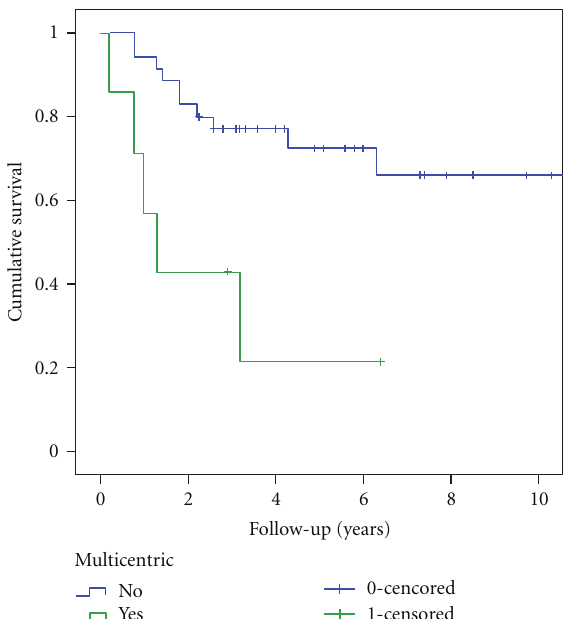
Figure 1: Kaplan-Meier overall survival curves comparing patients with and without multicentric-metastatic disease at diagnosis. Log Rank univariate analyses demonstrated significance ( P = 0 . 004).